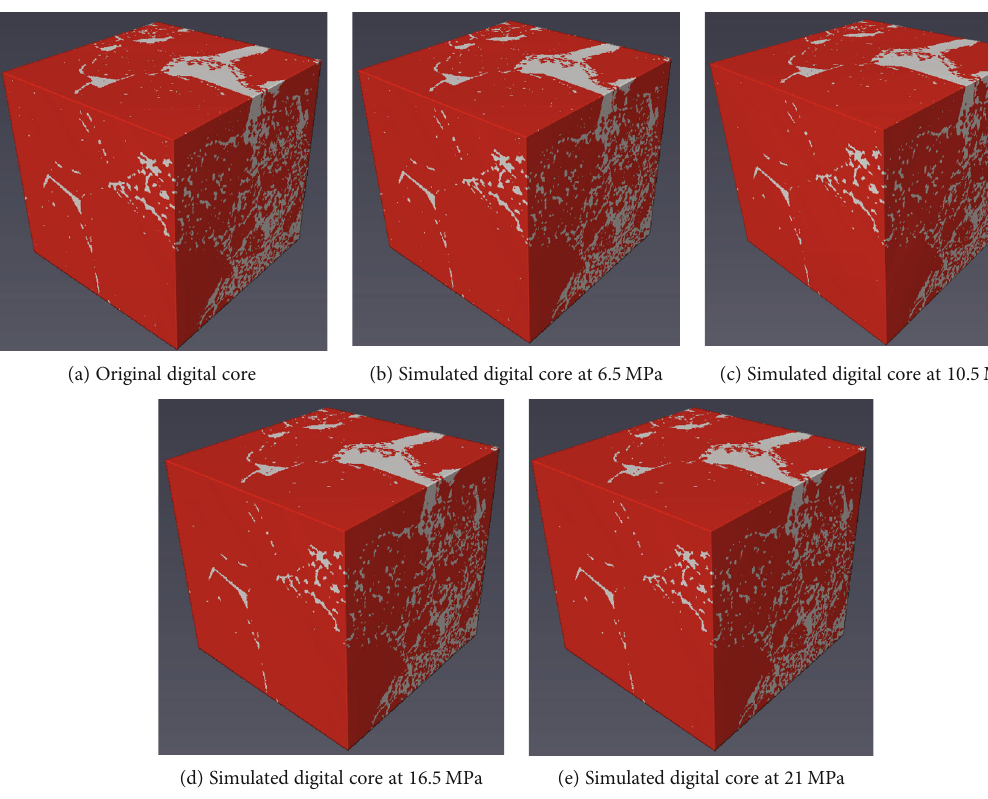
Figure 11: A series of simulated digital cores at di ff erent stress